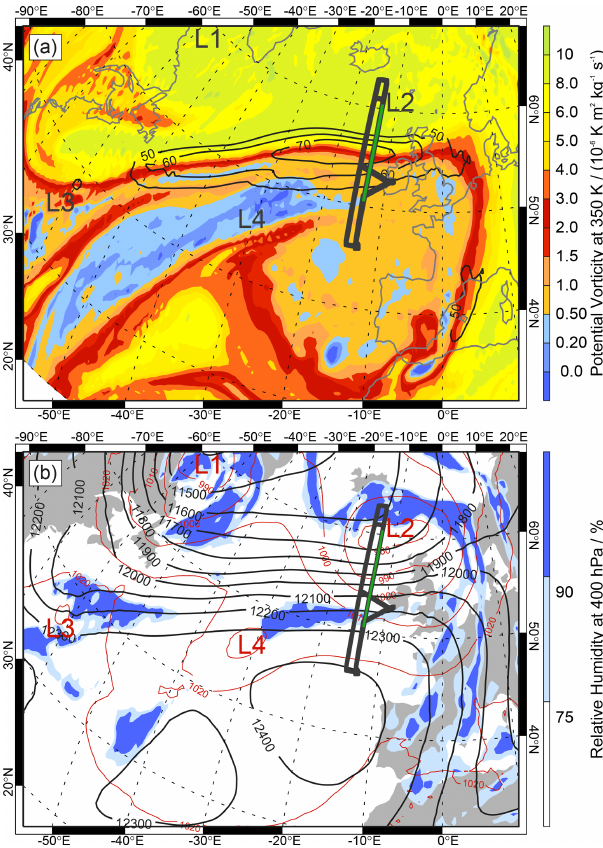
Figure 1. (a) Potential vorticity (in colors; 10 − 6 Km 2 kg − 1 s − 1 = 1 PVU) and horizontal wind speed (black contour lines; in ms − 1 for > 50ms − 1 ) at 350K. (b) Relative humidity at 400hPa (colors; in %), geopotential height at 150hPa (black contour lines; in m) and surface pressure (red contour lines; in hPa) as represented in the ECMWF operational analysis on 1 October 2017, 18:00UTC. L1–L4 mark the location of surface cyclones. Panels (a) and (b) are superimposed by the HALO flight track (12:05–21:57UTC; thick black line) and the subsection from 18:40 to 20:00UTC (green line) that is discussed in this